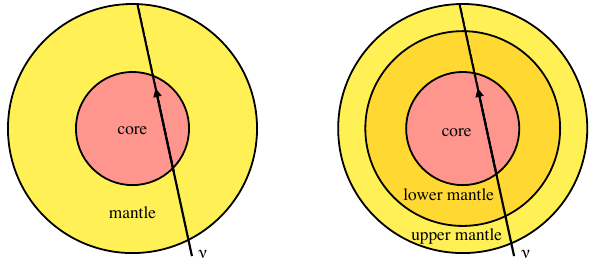
Figure 1 . Pictorial representation of toy 2-layer Earth model (left) and 3-layer model (right).